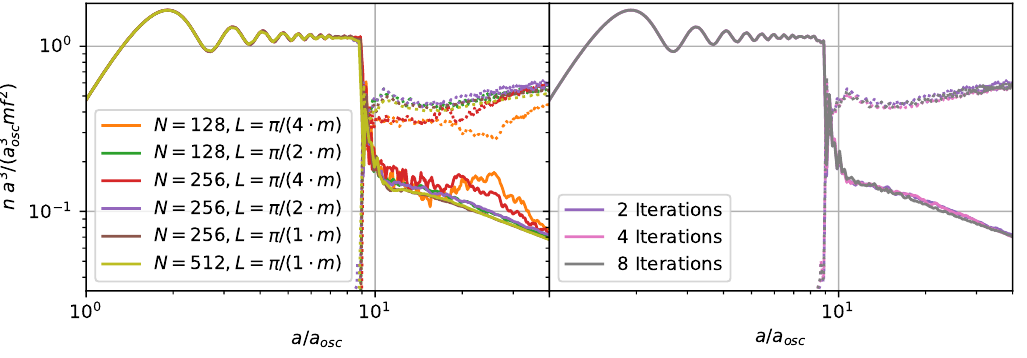
Figure 1: Comoving axion (solid) and dark photon (dotted) number densities for different choices of the lattice parameters with α = 60 and θ = 1 held fixed. Here, the number density refers to the volume averaged value, which includes the contribution from the zero mode as well as from fluctuations. In the left panel, L and N are varied while the number of iterations in the implicit scheme is held fixed at 2. Similarly, the right panel fixes N = 256, L = π/ ( 2 m ) and varies the number of iterations in the implicit scheme. The different choices agree to within ∼ 10% except in the case of the smallest length L = π/ ( 4 m )